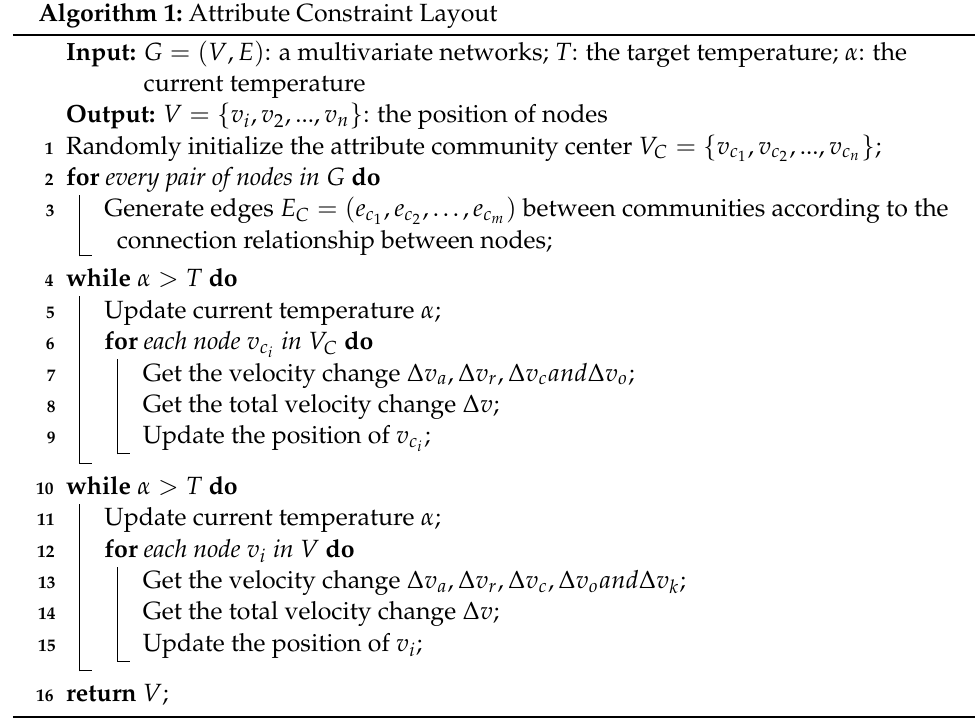
Algorithm 1: Attribute Constraint